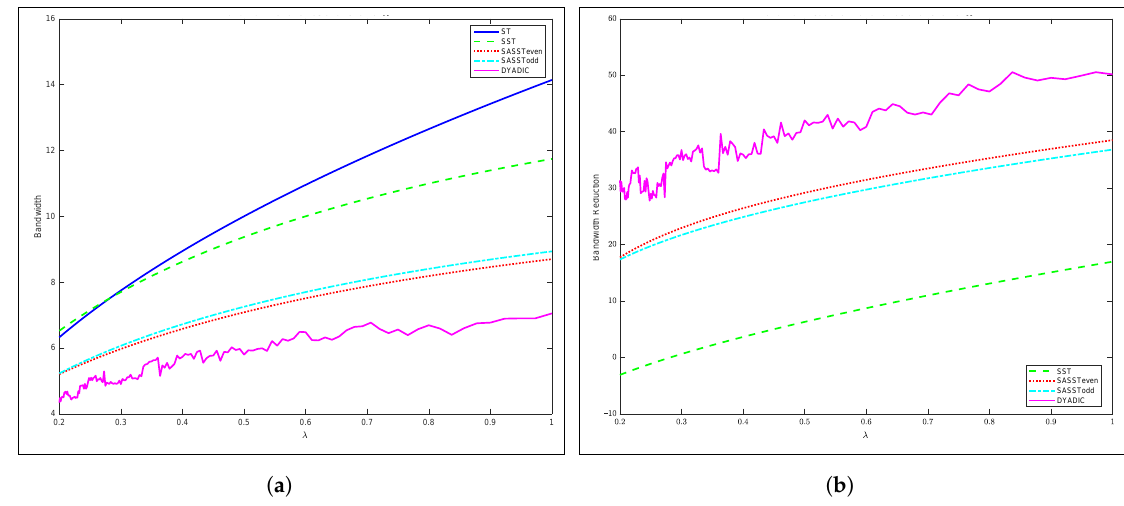
Figure 5. Comparison of bandwidth and bandwidth reduction between SASST, SST, ST and Dyadic as a function of the request arrival rate λ , respectively. ( a ) Bandwidth; ( b ) Bandwidth